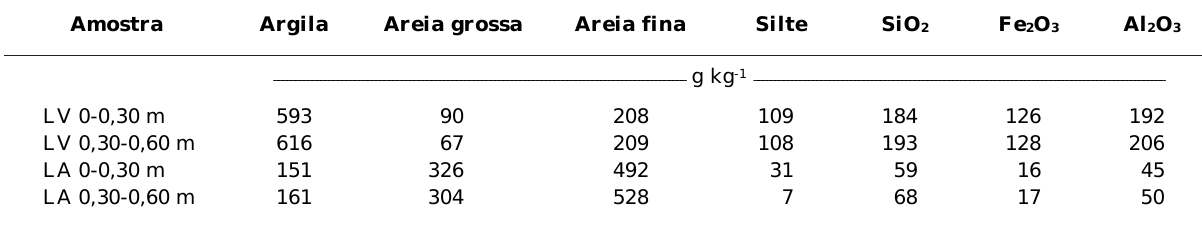
Quadro 2. Granulometria e óxidos (1) de silício, ferro e alumínio dos solos utilizados na instalação do